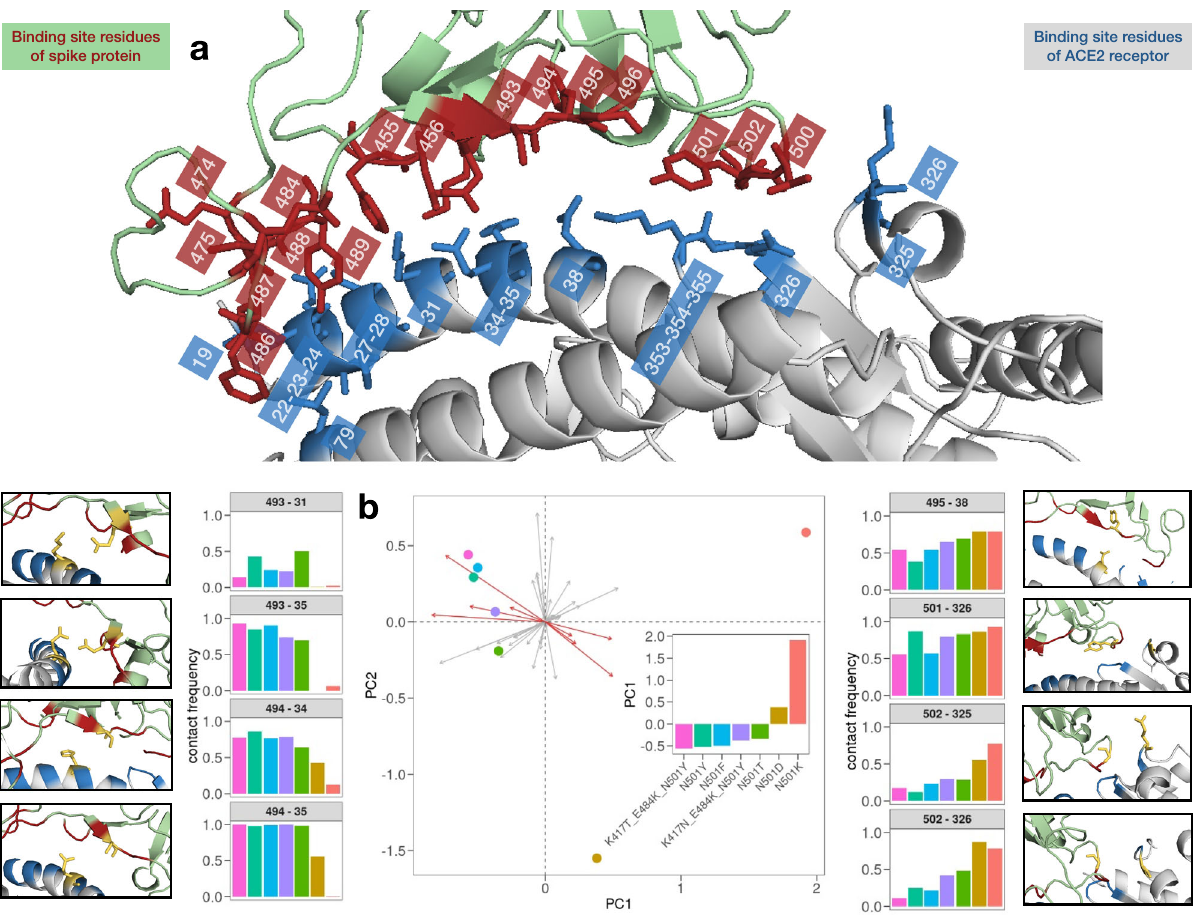
Fig. 4 Analysis of the covariance in the motion of the interacting residues. a Ribbon representation of the binding site of the SARS-CoV-2 spike protein bound to human ACE2 (PDB id: 6M0J). Interacting residues, i.e., the ones whose α -carbons have a distance lower than 9 Å , are represented with red sticks for the spike protein and with blue ones for the ACE2 receptor. b Projections on the two principal components of the analyzed variants (colored dots). Principal component analysis was performed over the contact probabilities of each couple of interacting residues reported in panel ( a ). The inset shows the projections on the fi rst component. Side plots display the contact probability values for the eight couples of residues that contributed the most in differentiating the variants in the principal component